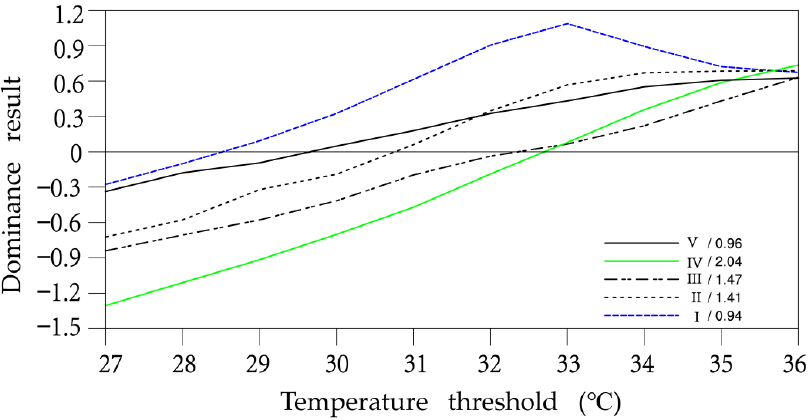
Figure 6. Dominance results of the five regions change with the threshold. The numbers in the legend are the average transition rates of each region. The green line is the area with the largest transition rate, the blue line is the area with the smallest transition rate.